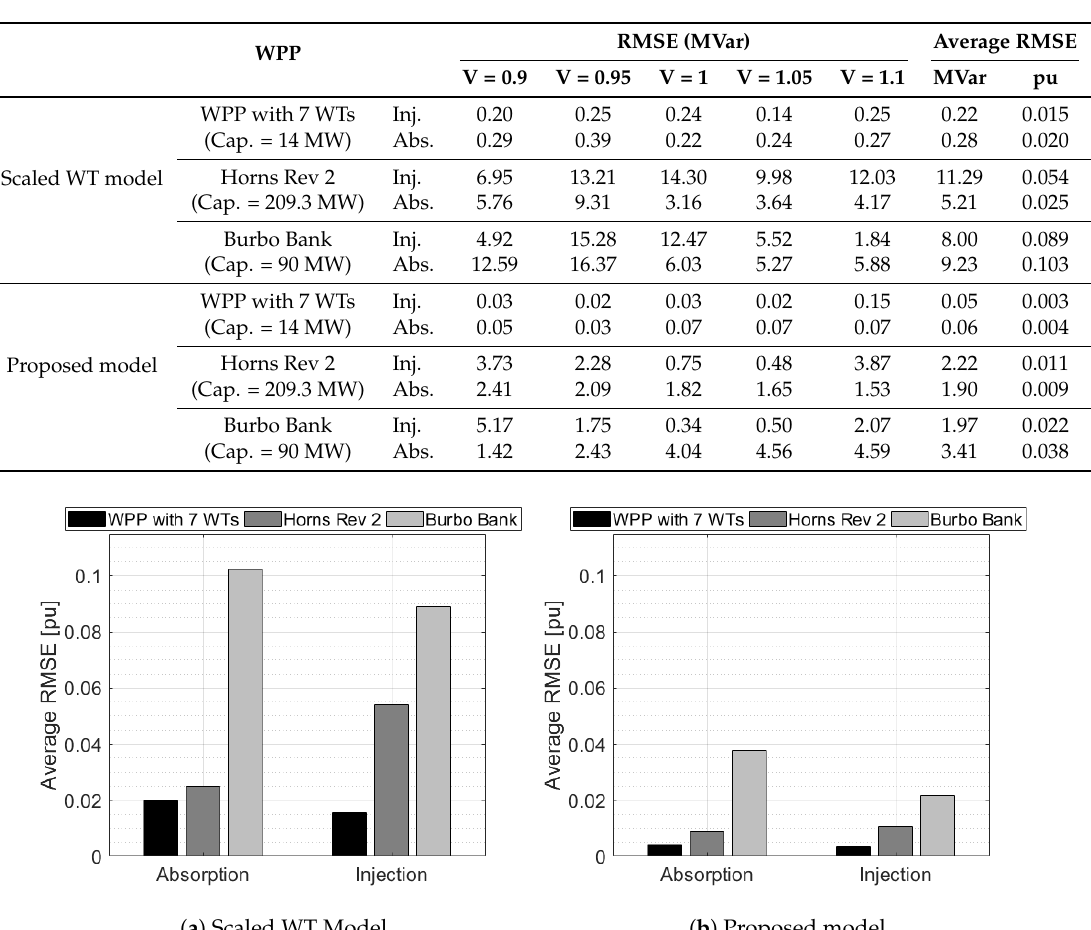
Table 3. The average root mean square error (RMSE) of calculated reactive power for three different WPPs at different voltage levels when using proposed model and scaled WT model compared to detailed WPP model.